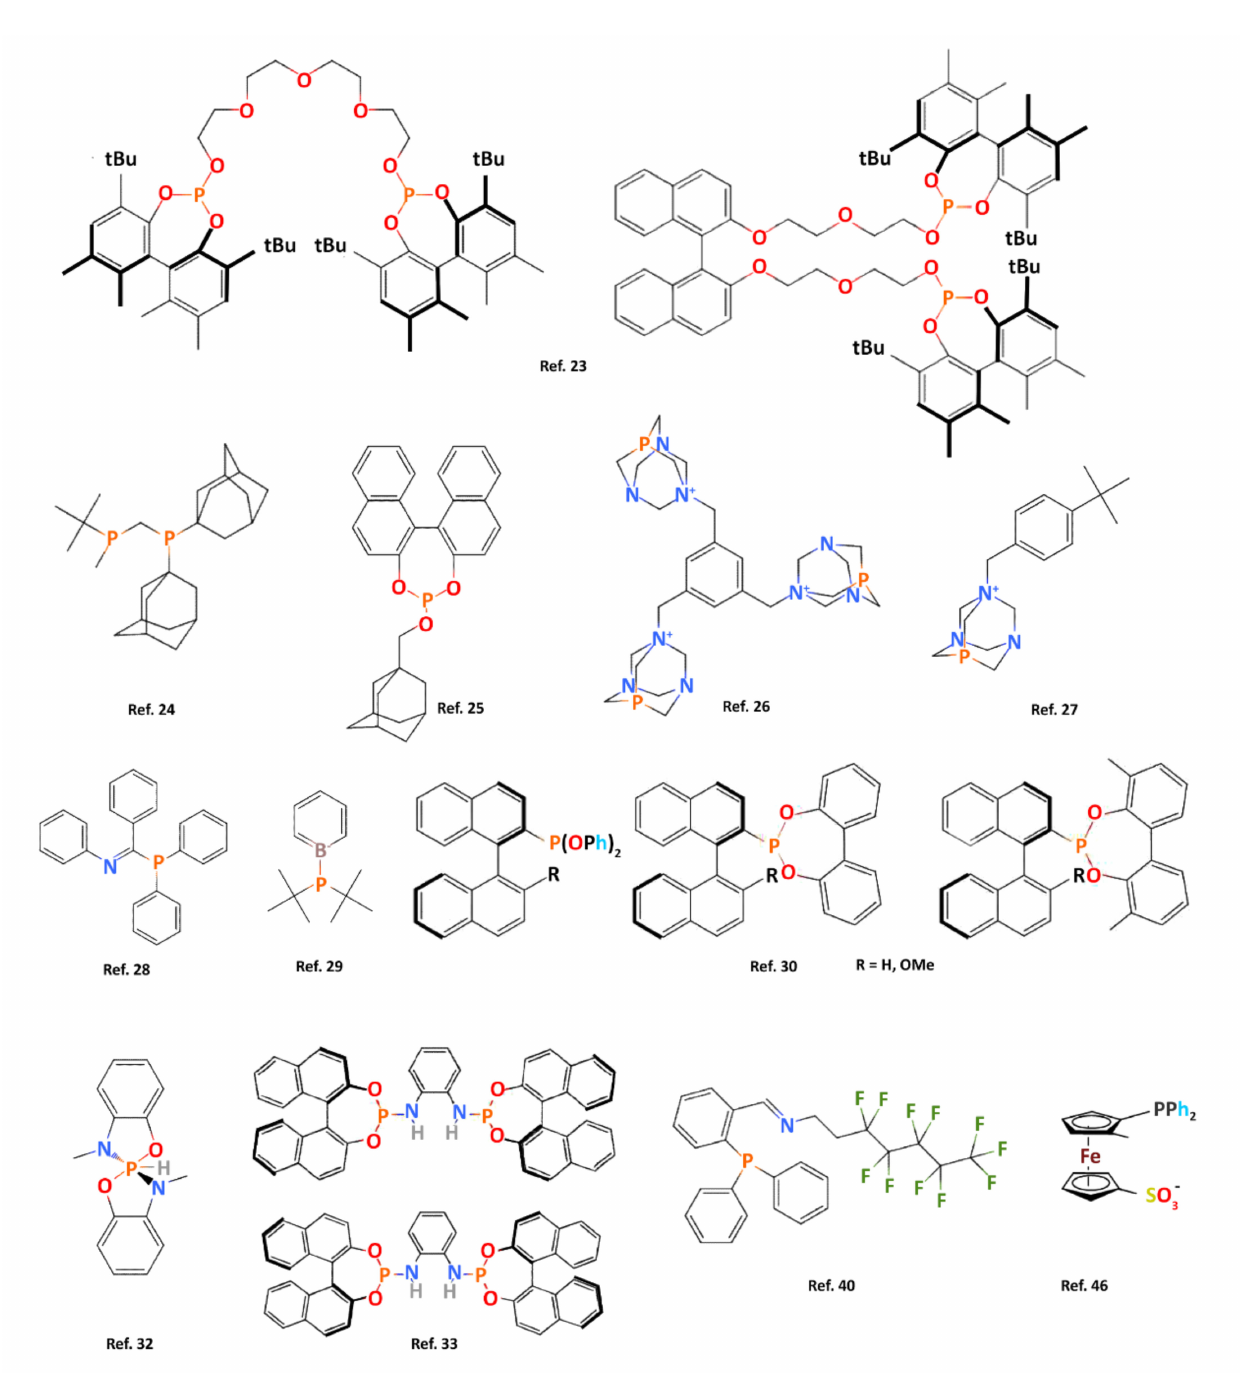
Figure 1. Molecular structures of some P-ligands in recent